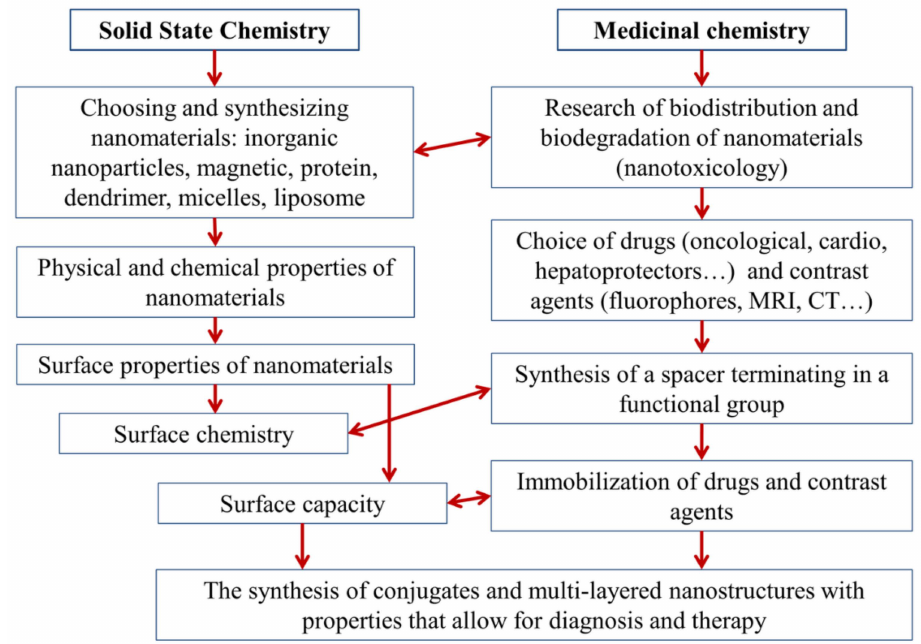
Figure 3. General synthesis diagram of platforms for